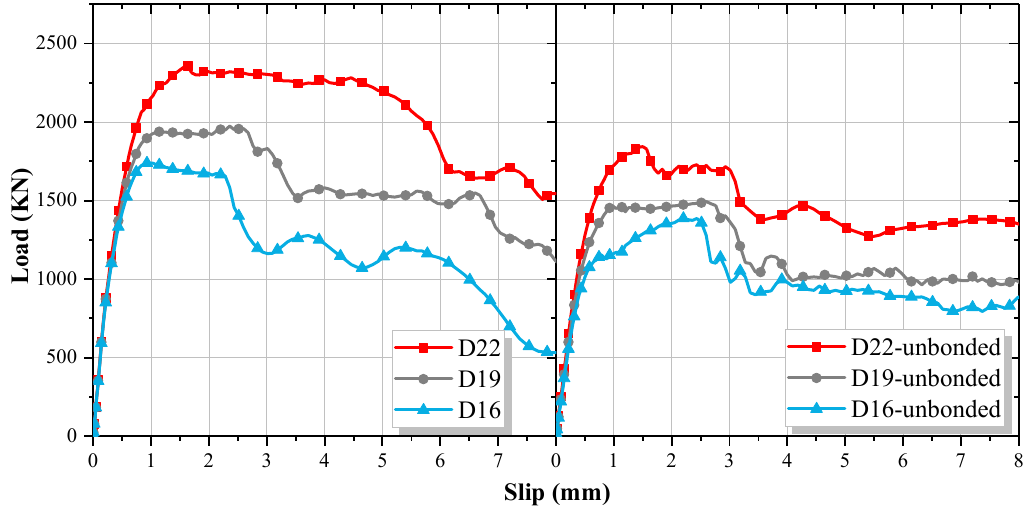
Figure 18. Load-slip curves of specimens with different stud diameter.